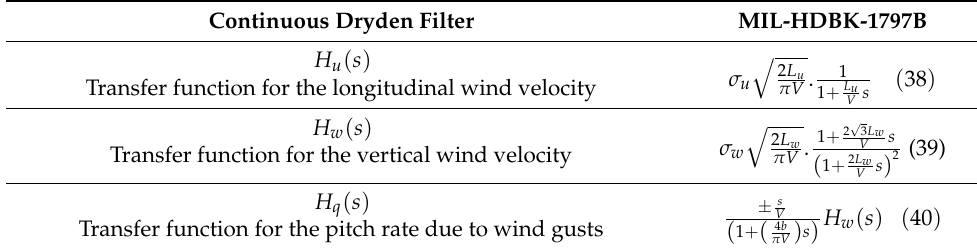
Table 1. Transfer functions for velocity spectra